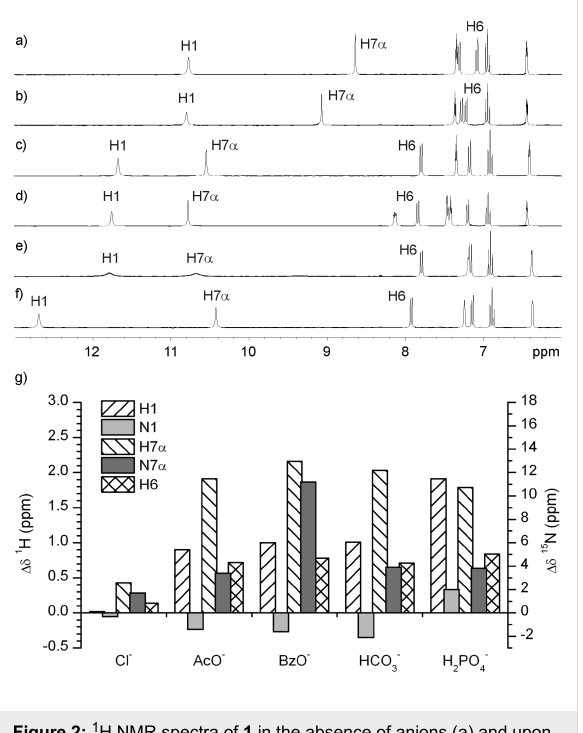
Figure 2: 1 H NMR spectra of 1 in the absence of anions (a) and upon addition of one equivalent of the following anions: Chloride (b), acetate (c), benzoate (d), bicarbonate (e) and dihydrogen phosphate (f). All spectra were recorded in DMSO- d 6 at 298 K. (g) 1 H and 15 N NMR chemical shift changes, Δδ = δ (in the presence of anion) – δ (in the absence of anions), induced by addition of one equivalent of different anions to receptor 1